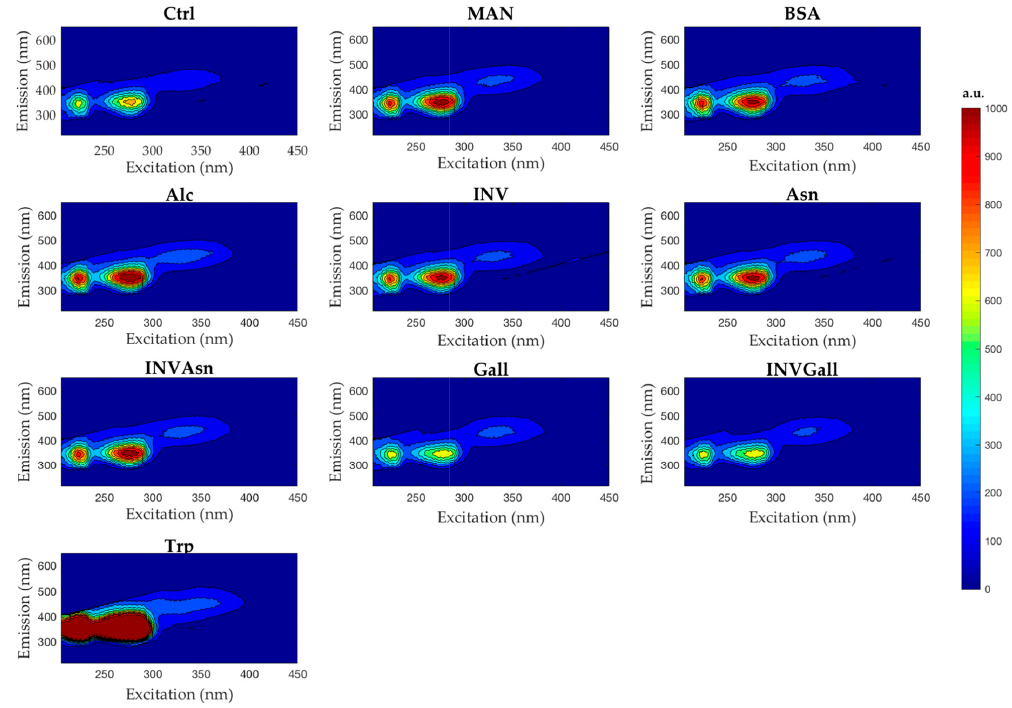
Figure 2. Fluorescence excitation and emission contour plots of the experimental wines. Ctrl, control; MAN, mannoprotein; BSA, bovine serum albumin; Alc, alcohol; INV, yeast invertase; Asn, asparagine; INVAsn, yeast invertase + asparagine; Gall, gallic acid; INVGall, yeast invertase + gallic acid, Trp, tryptophan. Table 3. Emission wavelength and the corresponding fluorescence intensity following λ ex 278 nm. Sample λ em FI Control 350 52,222